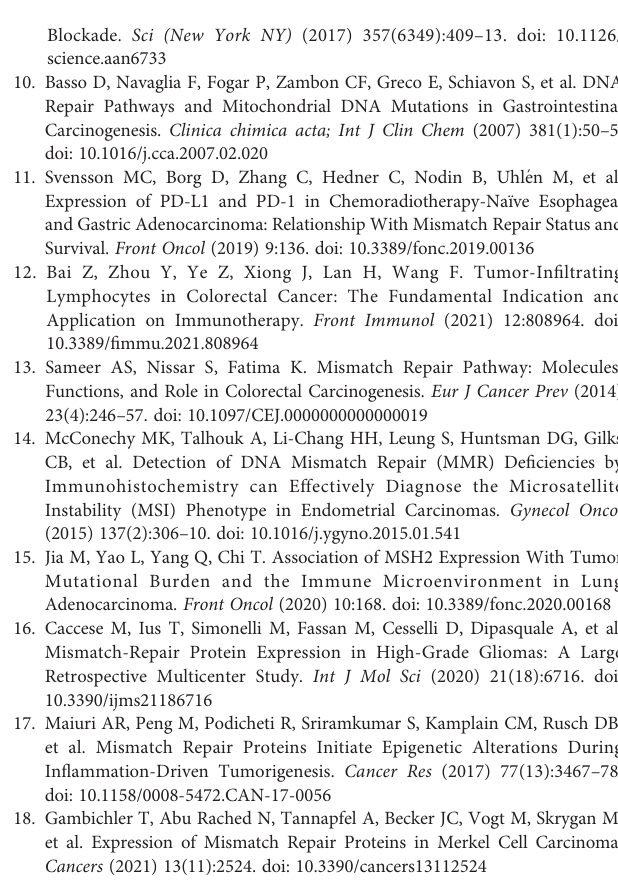
Supplementary Figure 1 | (A, B) There was no association between PMS2 de fi ciency and DFS ( P =0.964) or OS ( P =0.906). Supplementary Figure 2 | (A, B) In subgroup analyses for patients with high PMS2 expression, patients with PD-L1 expression tended to have better DFS ( P =0.103) and OS ( P =0.190) than those without PD-L1 expression, which were not found in subgroup analyses for patients with low PMS2